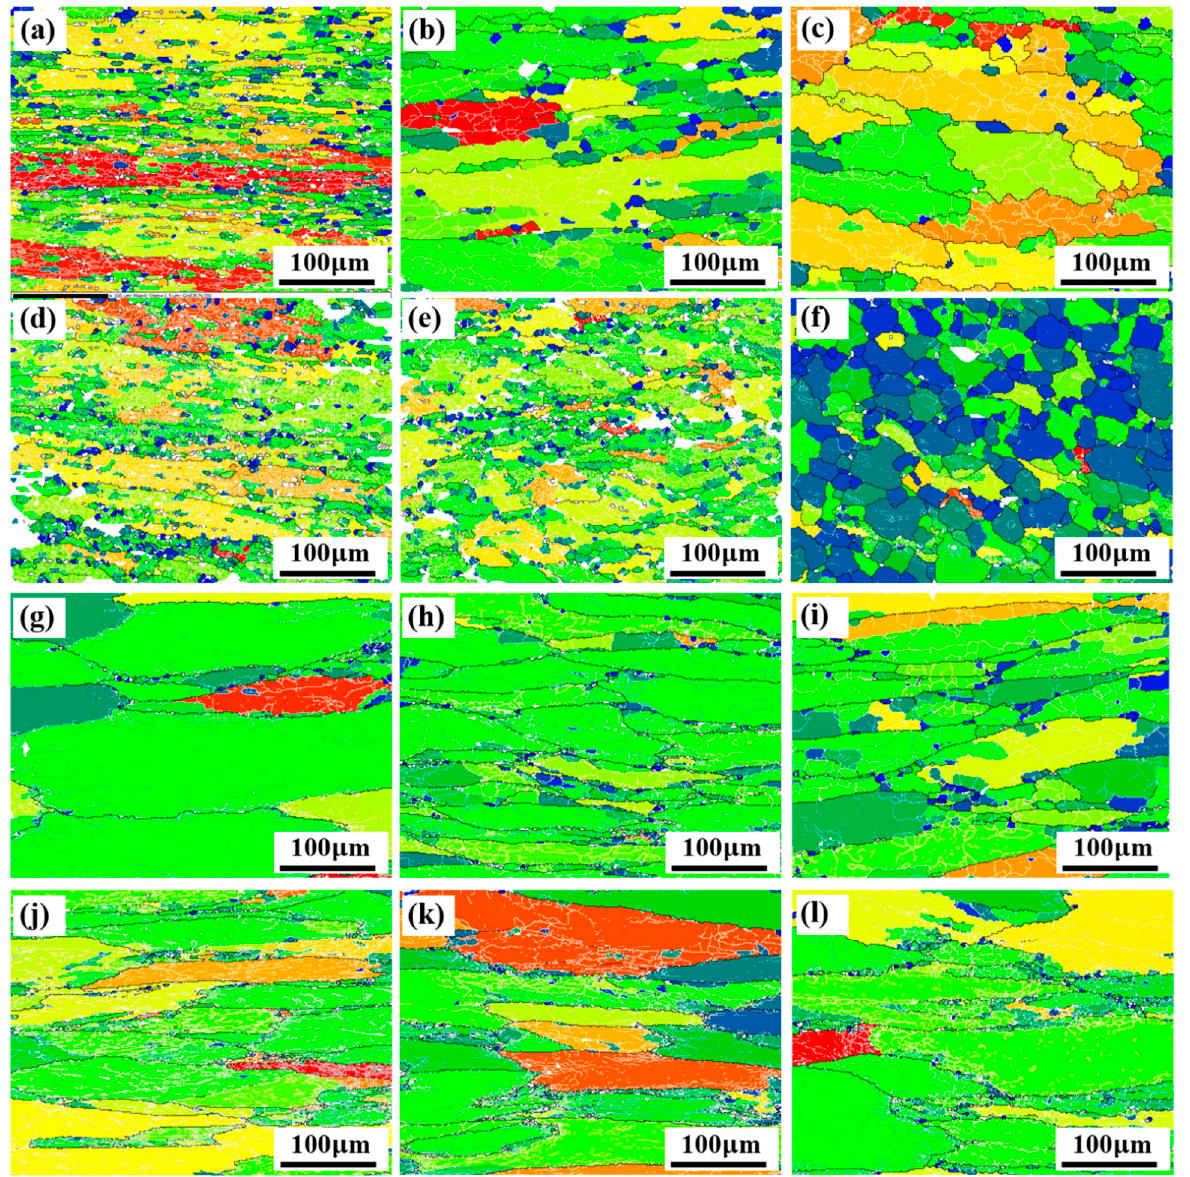
Figure 11. Grain orientation spread (GOS) plots of AC and HG AA2195 alloy in different deformation conditions: ( a ) AC-360 °C /0.01s − 1 , ( b ) AC-420 °C /0.01s − 1 , ( c ) AC-480 °C /0.01s − 1 ; ( d ) AC-360 °C /10s − 1 , ( e ) AC-420 °C /10s − 1 , ( f ) AC-480 °C /10s − 1 ; ( g ) HG-360 °C /0.01s − 1 , ( h ) HG-420 °C /0.01s − 1 , ( i ) HG-480 °C /0.01s − 1 ; ( j ) HG-360 °C /10s − 1 , ( k ) HG-420 °C /10s − 1 , ( l ) HG-480 °C /10s − 1 .